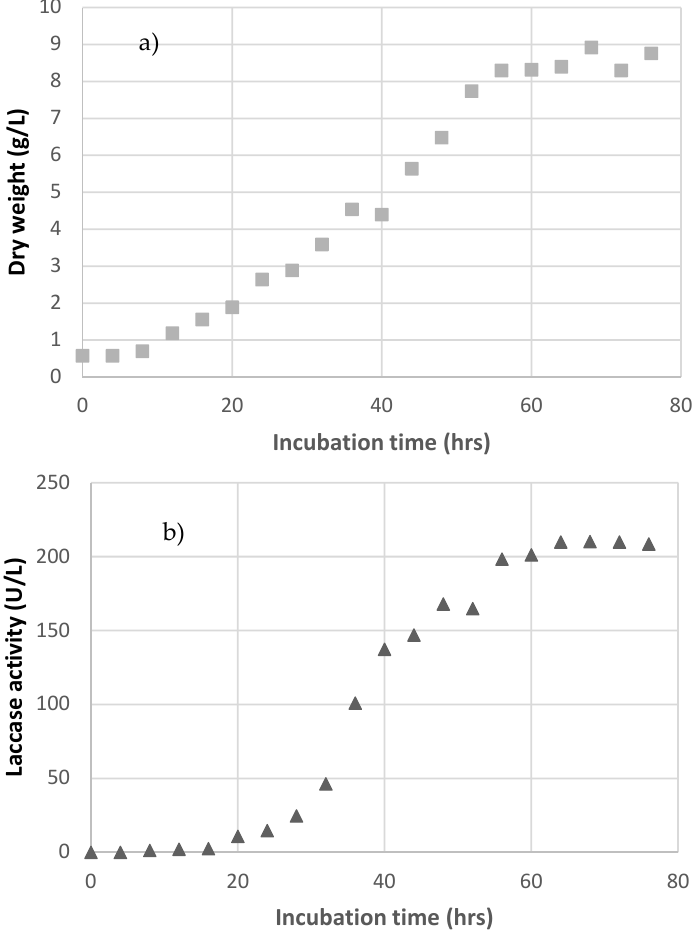
Figure 1. Time course study of dry weight ( a ) and laccase activity ( b ) during batch cultivation of P. neostrigosus I9 in 1.5 L tomato juice medium (diluted 1:3 v / v ) at 28 °C, 750 rpm.